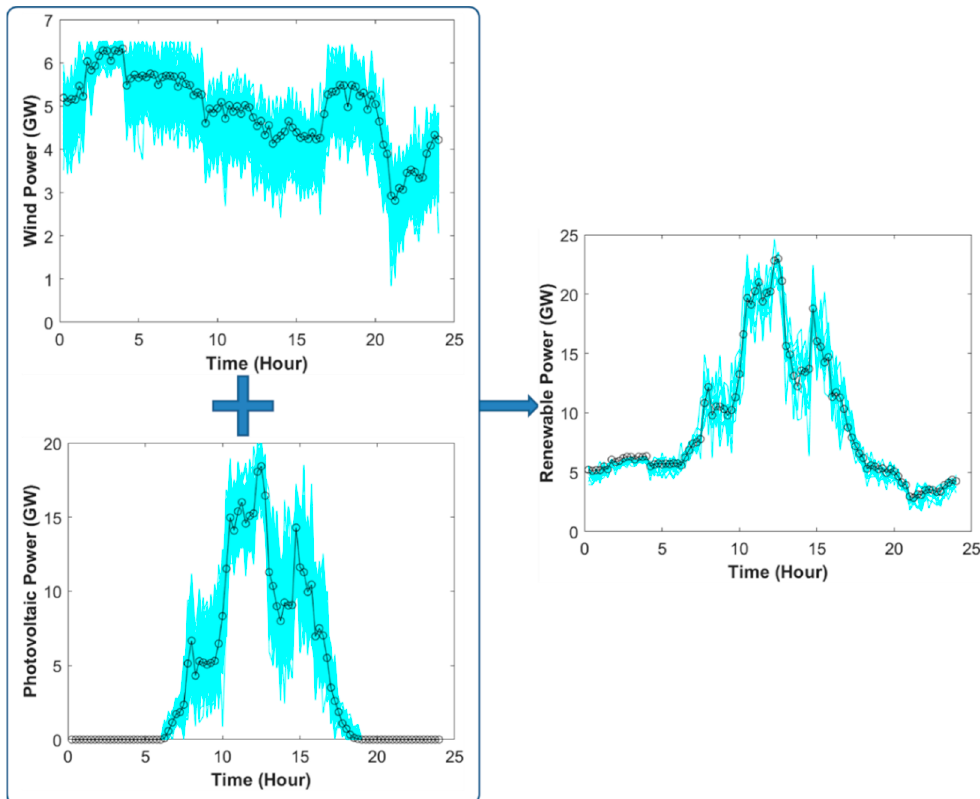
Figure 3. Diagram of renewable-energy scenario reduction.